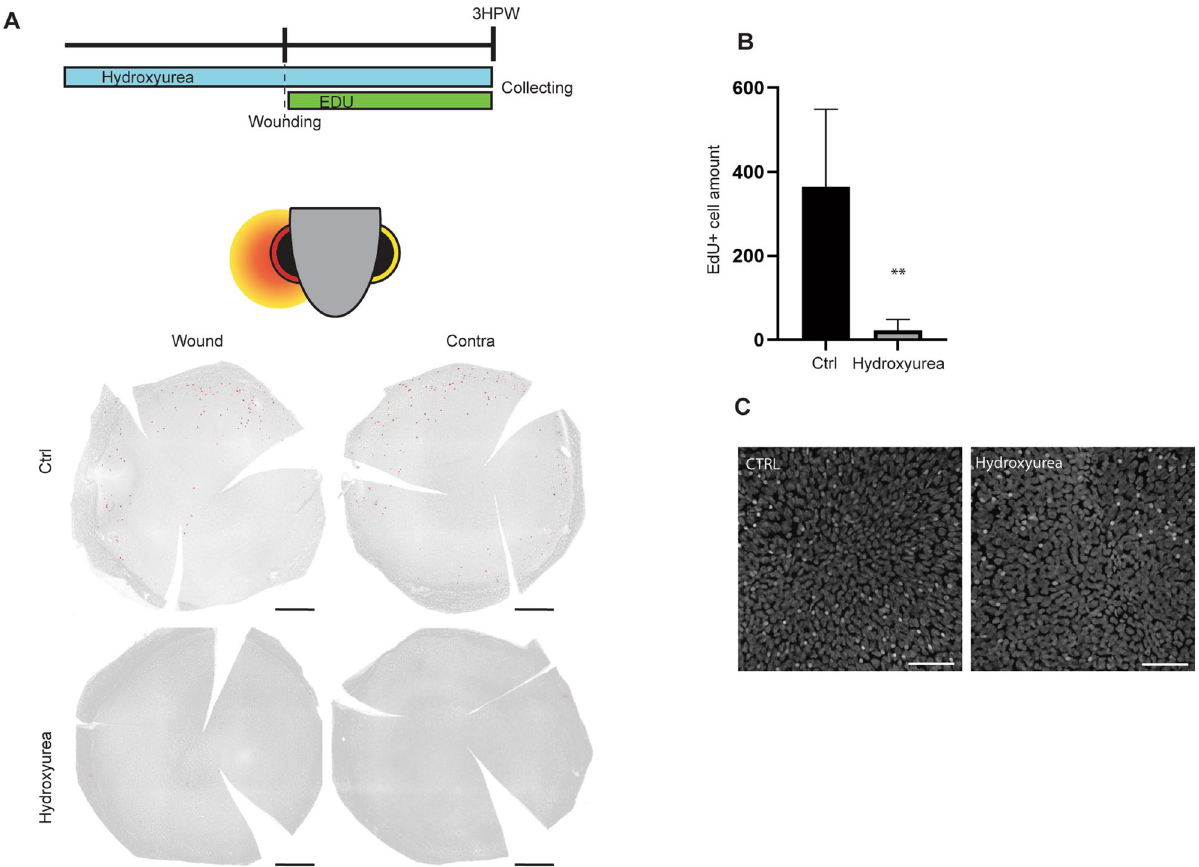
Figure 3. Impact of hydroxyurea on proliferation and wound closure. ( A ) While Hydroxyurea treatment is performed during 6 h (3 h pre- and 3 h post-abrasion), EdU incorporation is performed during the 3 h post- abrasion. Whole mount staining of EdU+ cells reveals the arrest of EdU incorporation due to hydroxyurea treatment. ( B ) The quantification of the EdU+ cells from ( A ) confirms the significant arrest of EdU incorporation under hydroxyurea treatment, n = 6 per group. ( C ) Hoechst staining on wound site in control versus hydroxyurea-treated animal demonstrated a complete wound closure, and the absence of potentially defected cells. Quantification data represent mean + stdev, ** P < 0.01, , Mann–Whitney test (exact p value, two- tailed) for comparing two groups. Scale bars: 300 µm in A, 50 µm in C. HPW: hours